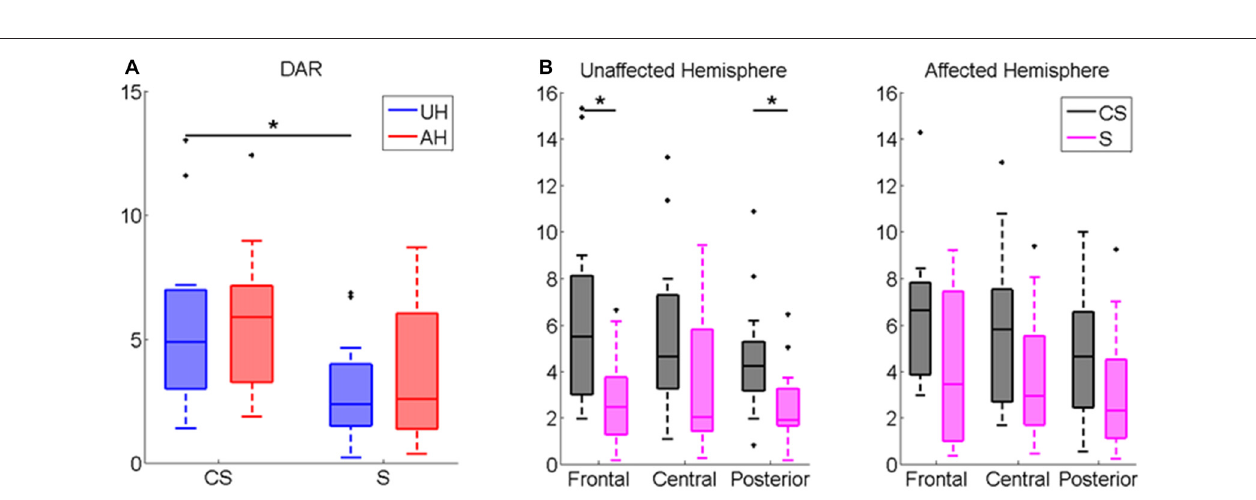
FIGURE 3 | Delta/Alpha Ratio (DAR) Index computed for (A) UH and AH and for (B) Frontal, Central and Posterior Area in each hemisphere (UH and AH). Median and IQR of DAR in Cortico-subcortical lesioned patients (CS) and Subcortical lesioned patients (S). ∗ p < 0.05.